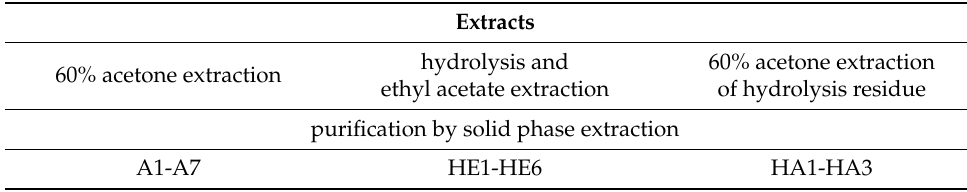
Table 2. Overview of the extract